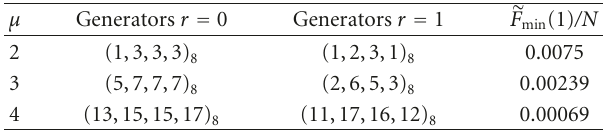
Table 4: Optimum overlays for rate 1 / (2 R ) with QPSK, n = 2, m = 1, R = 1, in quasistatic channel. The basic code for single transmitter is STC with best convolutional code for the AWGN channel.